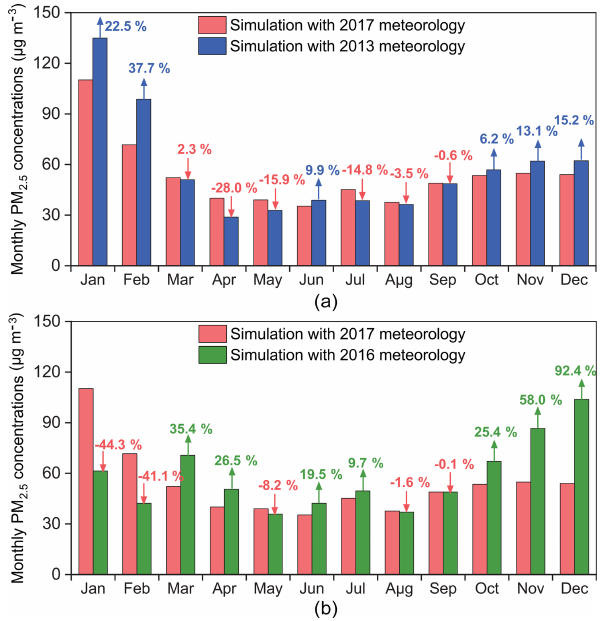
Figure 8. CMAQ-simulated monthly PM 2 . 5 concentrations in Bei- jing under different meteorological conditions. The numbers shown in each panel represent the monthly relative change rates of fixed- emission simulation results compared with the base simulation re-